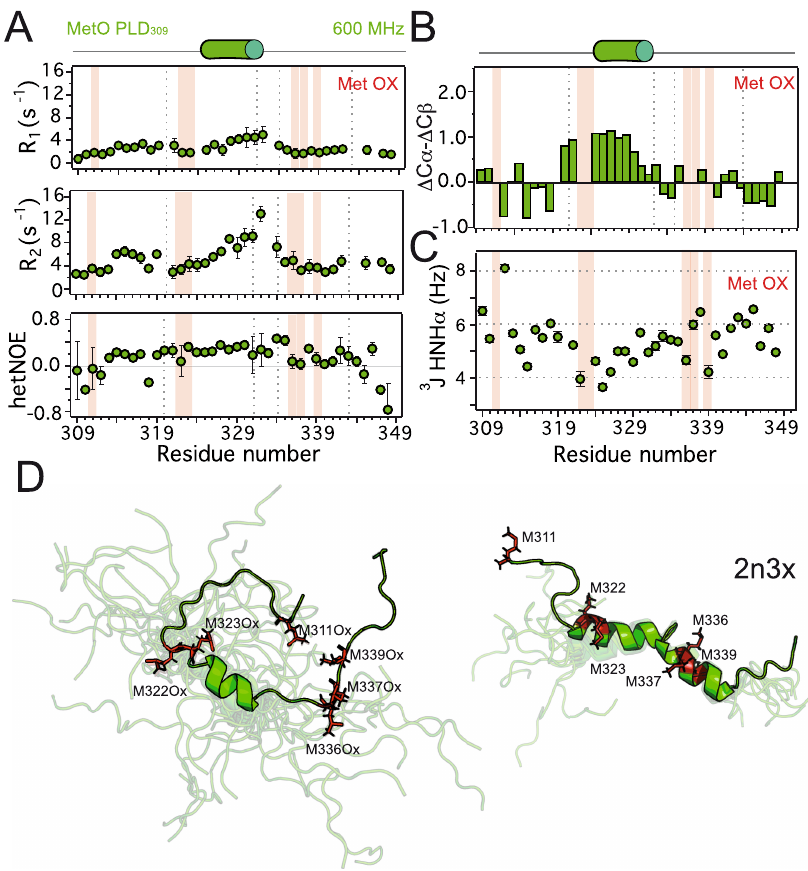
Fig. 3 | Methionine sulfoxidation promotes signi fi cant disorder in the PLD. A Longitudinal ( R 1 , top), transverse ( R 2 , middle) rate constants, and heteronuclear ( 1 H)- 15 NNOE(bottom)relaxationparameterswereobtainedforMetOPLD 309 at600 MHz. The values of all relaxation parameters indicate that the protein is highly dynamic. B Secondary chemical shifts ( Δ C α - Δ C β ) for MetO PLD 309 . C J-coupling assessment of the secondary structure propensities for MetO PLD 309 . Values around 4Hz indicate α -helix formation, while values around 8Hz are typical of β -strand structures. D Structural ensemble of the 20 conformers of MetO PLD with the lowest conformationalenergy ascalculated byCYANA(left),compared to